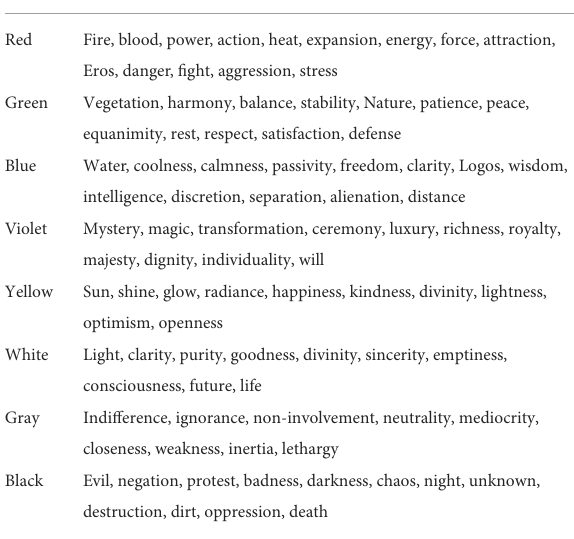
TABLE 1 Associative meaning of main colors.